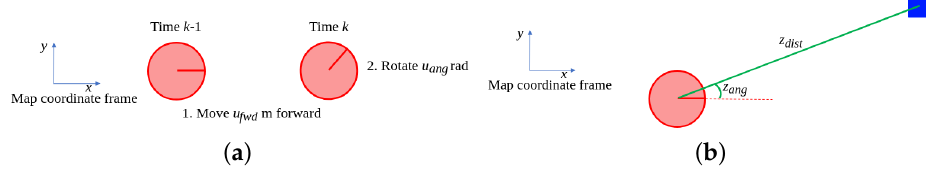
Figure 2. Visualizations of the process and measurement models used in the running example. The robot pose is denoted by the red circle, the landmarks are denoted by blue rectangles. ( a ) Process model used in the running example: the robot at time k − 1 on the left, predicted robot pose at time k on the right. ( b ) Measurement model used in the running example. Measurement z ang is defined with respect to the x -axis of the map coordinate frame. As a result, measurements are independent of the robot’s